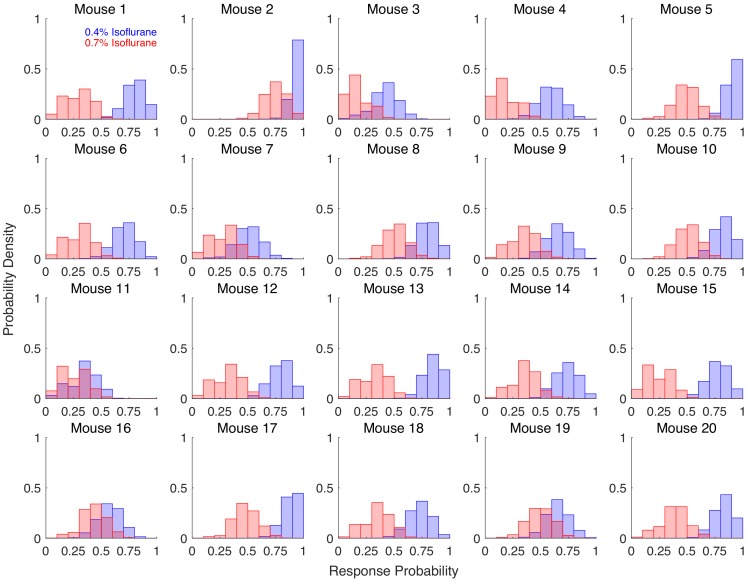
Ability to discriminate across two drug concentrations within individuals is highly variable.Individual response probabilities are shown for 20 mice exposed to 0.7% isoflurane (blue) and 0.4% isoflurane (red). Righting reflex (RR) was assessed every 3 min for the final 2 hrs of a 4-hr exposure, with 4 exposures at each concentration. Bootstrapped response probabilities (1,000 bootstraps of 20 samples with replacement) are shown for each individual. Degree of overlap between the two concentrations of isoflurane is highly variable, from almost zero overlap (as seen in mouse 13) to almost complete overlap (as seen in mouse 11).